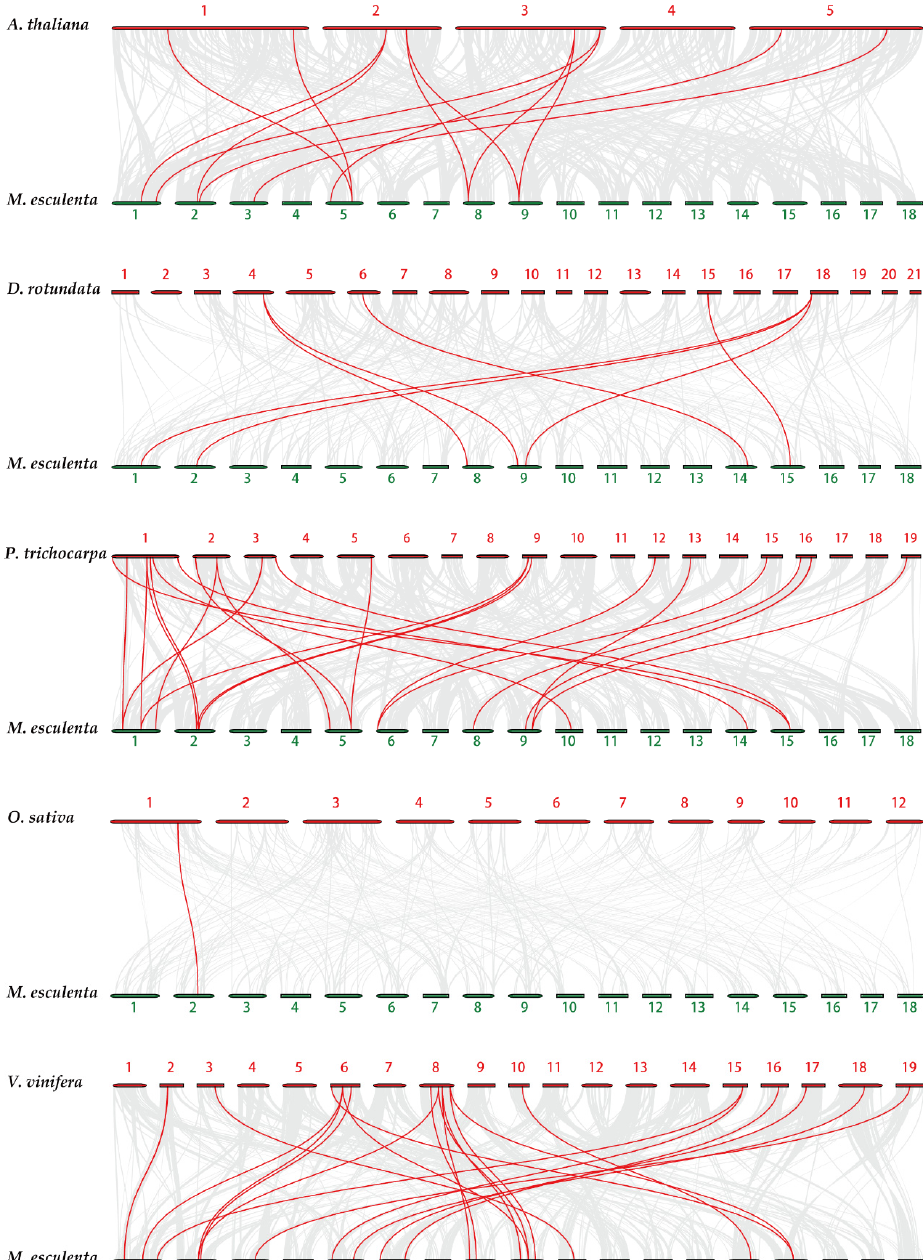
Figure 5. Synteny analysis of tubulin genes between cassava and five representative plant species. Gray lines in the background represent the collinear blocks within cassava and other plant genomes, while the red lines highlight the syntenic tubulin gene pairs. The species names with the prefixes ‘ M. esculenta ’, ‘ A. thaliana ’, ‘ D. rotundata ’, ‘ P. trichocarpa ’, ‘ O. sativa ’ and ‘ V. vinifera ’ indicate Manihot esculenta , Arabidopsis thaliana , Dioscorea rotundata , Populus trichocarpa , Oryza sativa , and Vitis vinifera , respectively.